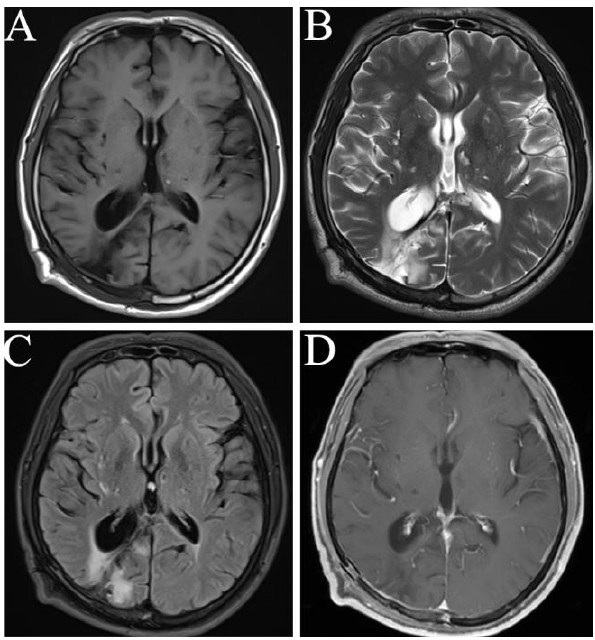
Figure 4. MRI manifestations in follow-up two years after surgery on 1 August 2022. T1WI ( A ), T2WI ( B ), T2 Flair ( C ), and contrast-enhanced T1 ( D ) show the postoperative changes, and no occurrence was observed.